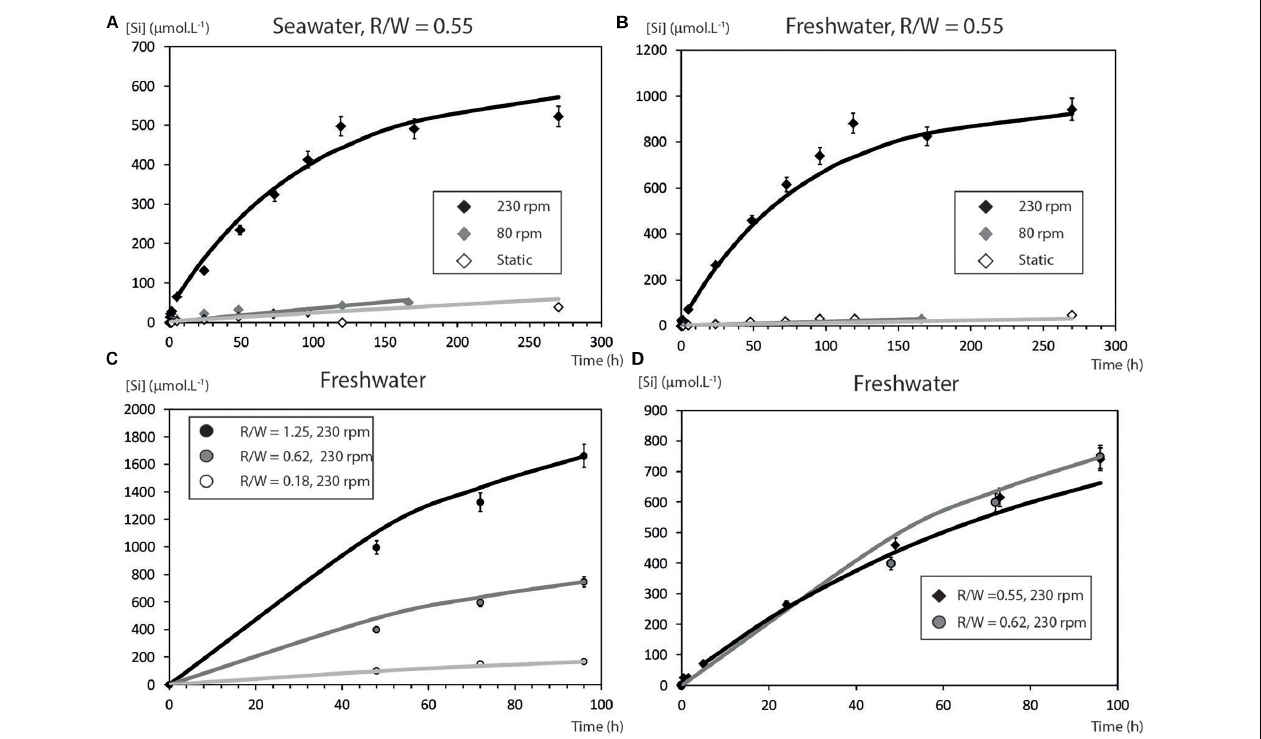
FIGURE 2 | Experimental results of sand grains dissolution at various rotation speeds. (A) Silica concentrations in seawater. (B) In deionized water. (C) Influence of the R/W ratio on the dissolution rate. (D) Reproducibility and sensitivity of the experiments, note the slight difference between R/W ratio of 0.55 and